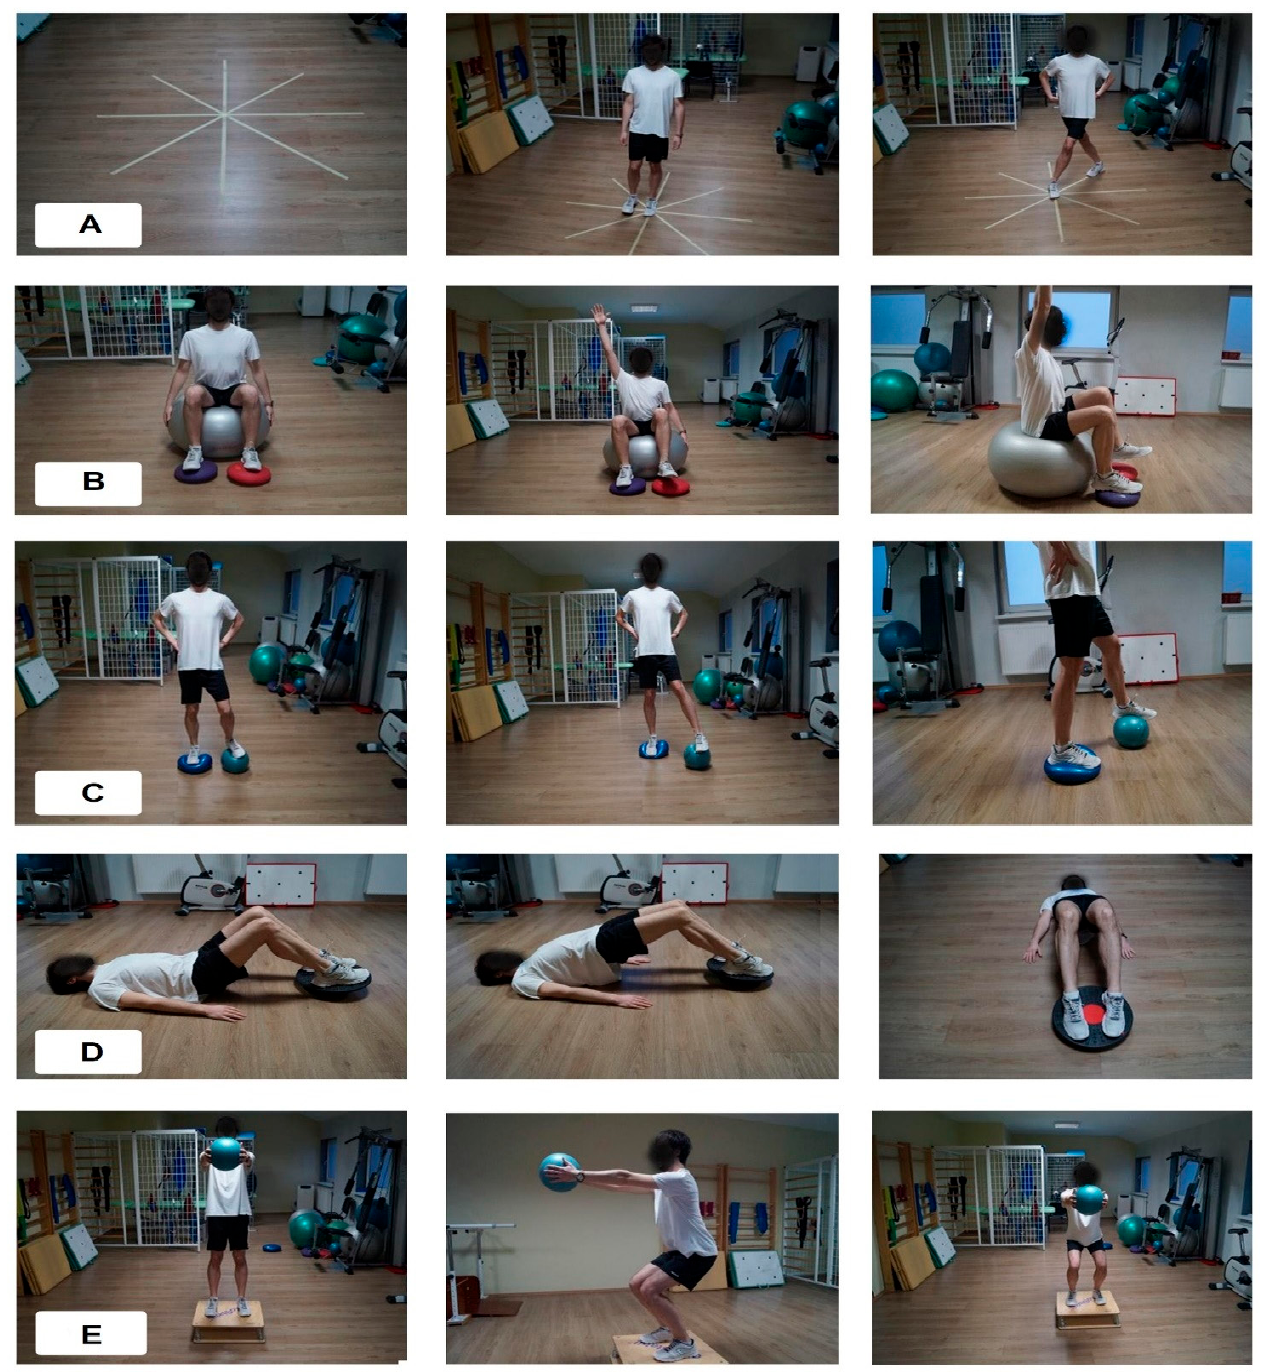
Figure 4. Introduced sensorimotor exercises: ( A )—exercise one: “star”, ( B )—exercise two: alternate lifts of upper and lower limbs while sitting on a Swedish ball, ( C )—exercise three: rolling a ball around the sensory disc, ( D )—exercise four: tilting with lower limbs on Domyos, and ( E )—exercise five : squats with a ball on an ortho-stable platform.